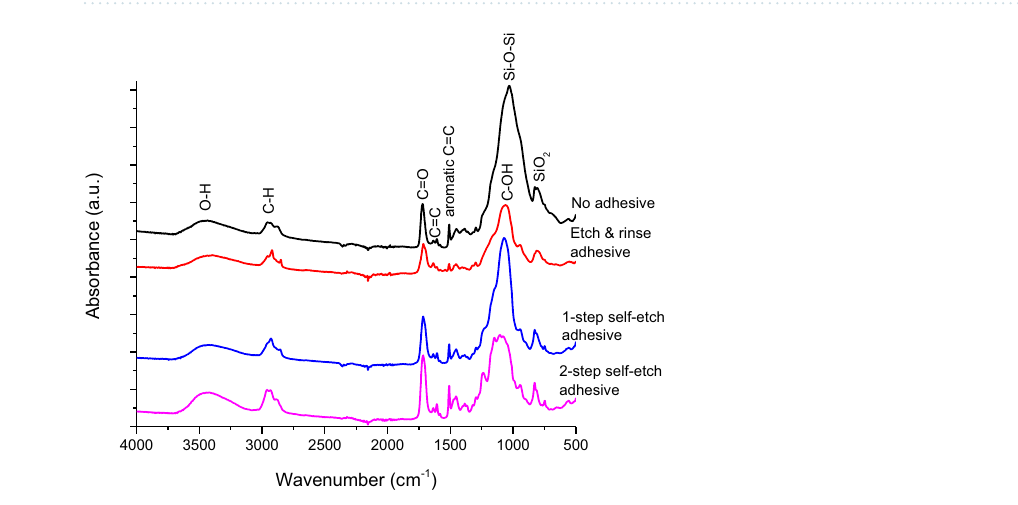
Figure 10. Representative Fourier-transform infrared spectra of adhesive-coated surface of the experimental composite E-20 before 32 days lactic acid